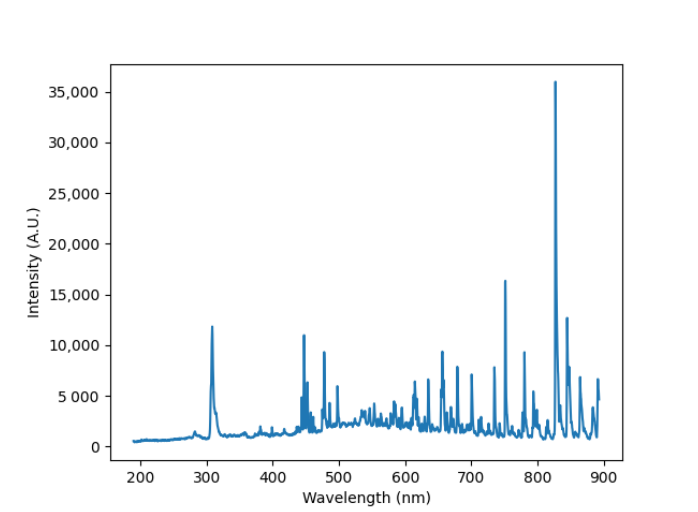
Figure 6. A sample of intensity patterns of each wavelength at the EPD time.